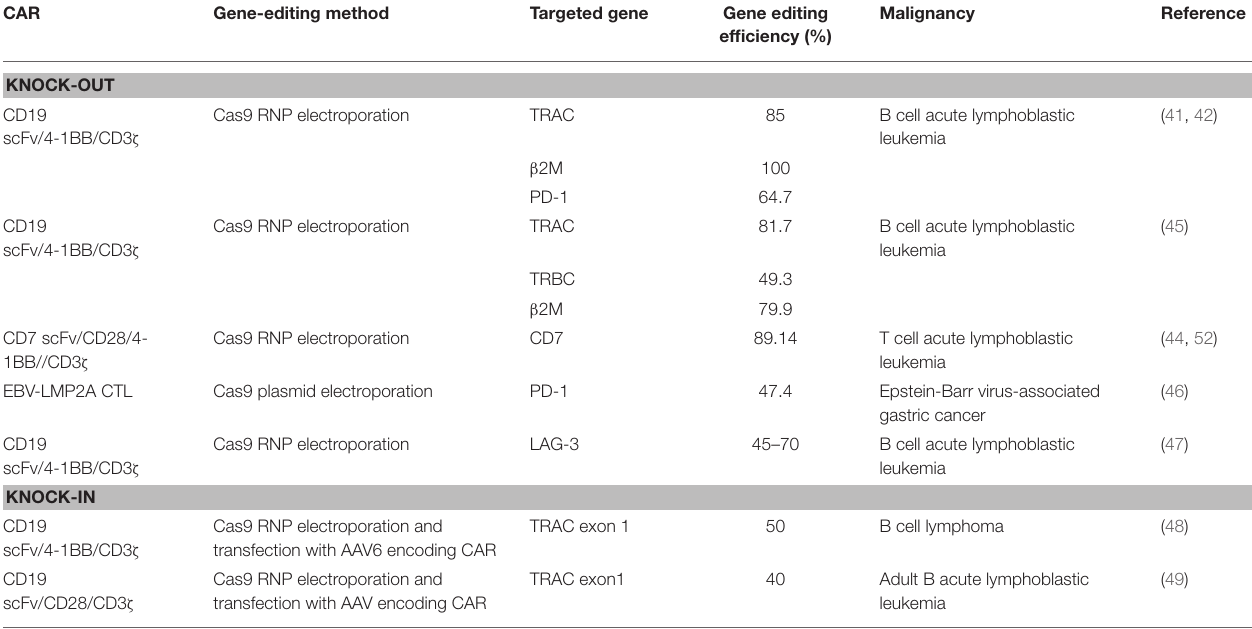
TABLE 2 | Summary of the CAR-T cells modified with gene